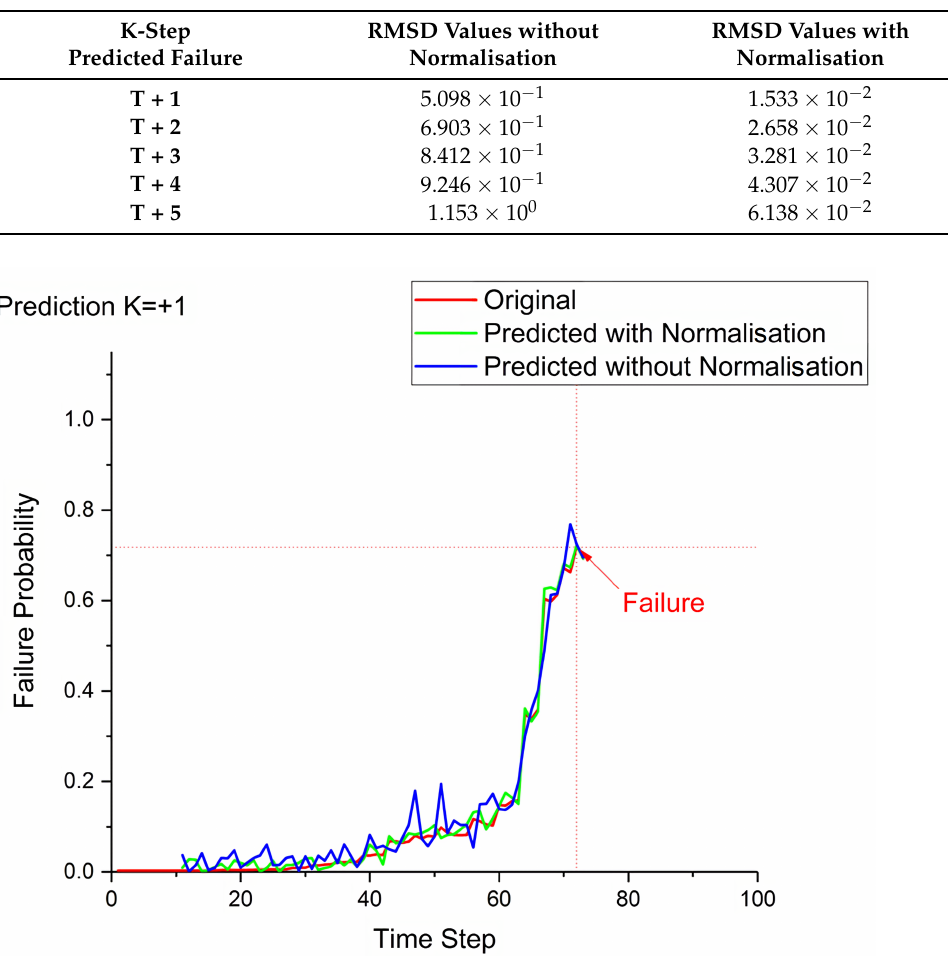
Table 3. RMSD of the k-step final estimation of failure probabilities.